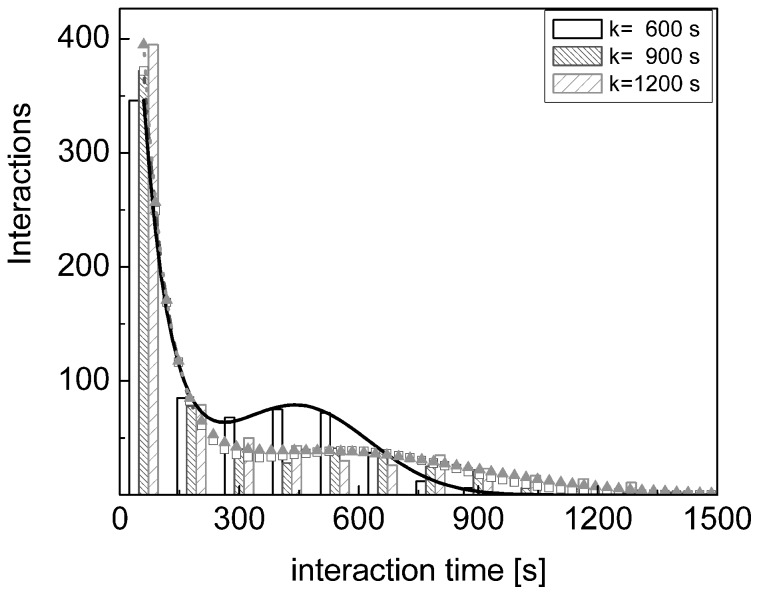
Dependence of the duration times of the interaction between NK and dendritic cells on the degradation time.Distribution of the duration time of the NK – dendritic cell interaction, as a function of the chemokines' degradation time, k: k = 600 s (open black bars, black continuous best fit line); k = 900 s (densely hatched red bars and red open squares best fit line) and k = 1200 s (sparsely hatched green bars and green filled triangles best fit line). The chemotactic parameter was set to . The lines are best fit to the trial function. Best fit parameters are: A (600s)  = 803±28, t1 (600s)  = 70±6s, B (600s)  = 78±2, t0 (600s)  = 450±6 s, σ (600s) = 250±14 s for k = 600s; A (900s)  = 859±37, t1 (900s)  = 70±6s, B (900s)  = 38±2.5, t0 (900s)  = 570±30s, σ (900s)  = 380±40s for k = 900s and A (1200s)  = 980±70, t1 (1200s)  = 66±6s, B (1200s)  = 38±3, t0 (1200s)  = 630±200s, σ (1200s) = 550±90s.